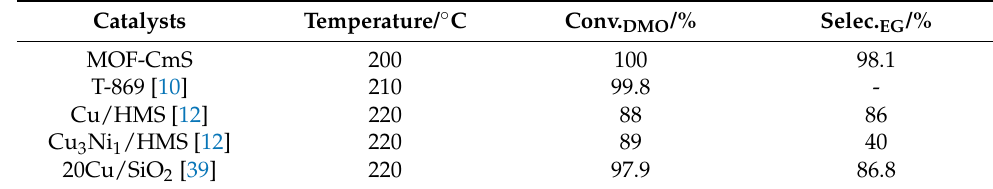
Figure 6. Schematic model of the reaction mechanisms over MOF-CmS catalyst for the hydrogenation of DMO. Table 1. Comparison of catalysts’ properties in the present work and other